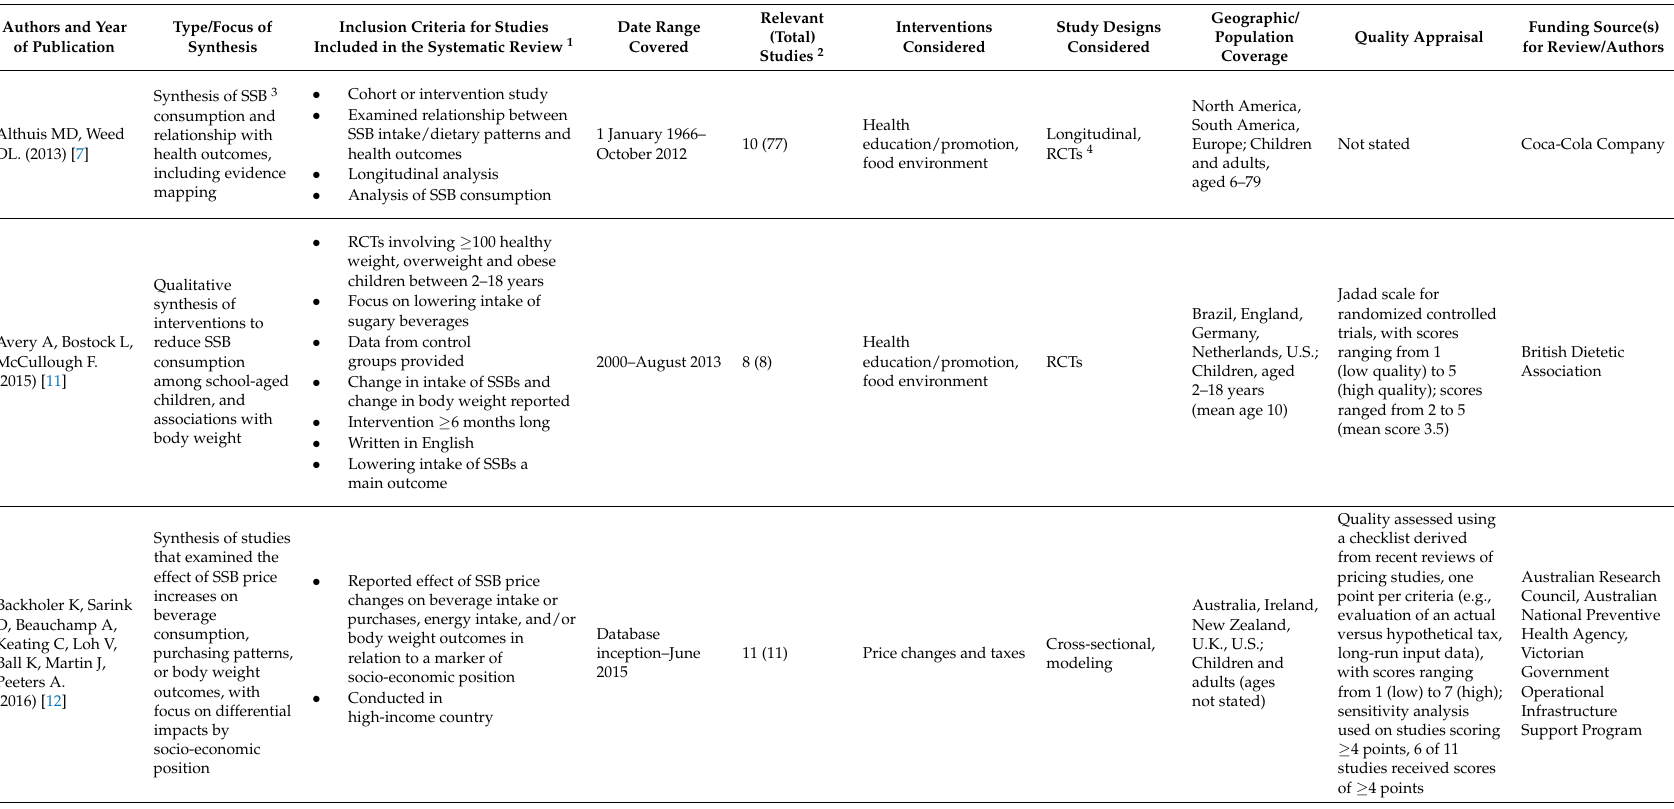
Table 1. Characteristics of systematic review articles ( n = 12) including at least one intervention study intended to reduce consumption of sugary